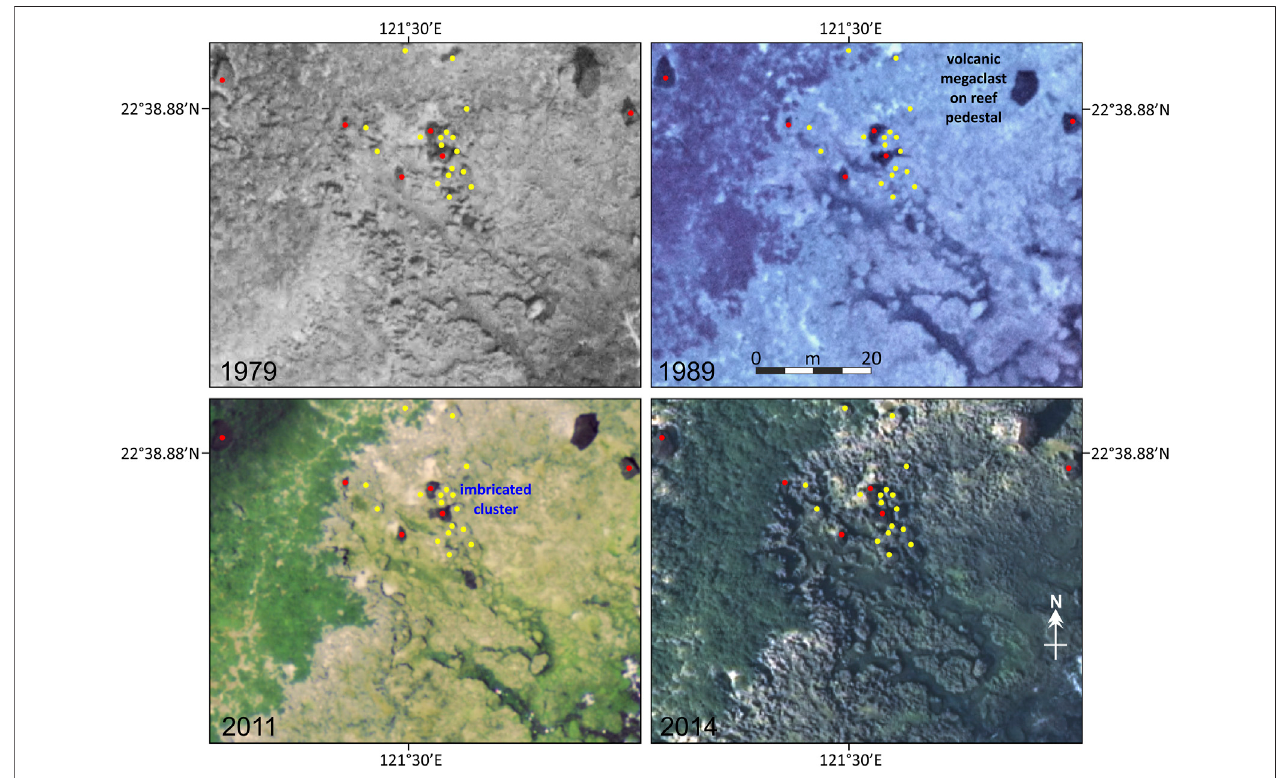
FIGURE 10 | A sequence of aerial photos and satellite images spanning nearly 4 decades, showing details a section of Dahu Reef approximately 70 m × 60 m in area. The location of the area covered by the images is indicated in Figure 3A . The stacked boulder clusters (SBCs), some of which display imbricate patterns, are located at the head of a relict channel network (remnant spur-and-groove formation) that forms relatively low-lying depressions on the reef platform. Comprising the group are clast lithologies of both volcanic agglomerate (red dots) and reef limestone (yellow dots). A selection of other measured isolated clasts is also shown. Comparisonbetweentheimagesshowsnosigni fi cantevidenceofwavetransportofanymeasuredlargeclasts(a-axis > 3 m)onDahuReef,eitherbyTyphoonTembinin 2012 or by typhoons in earlier decades since 1979.